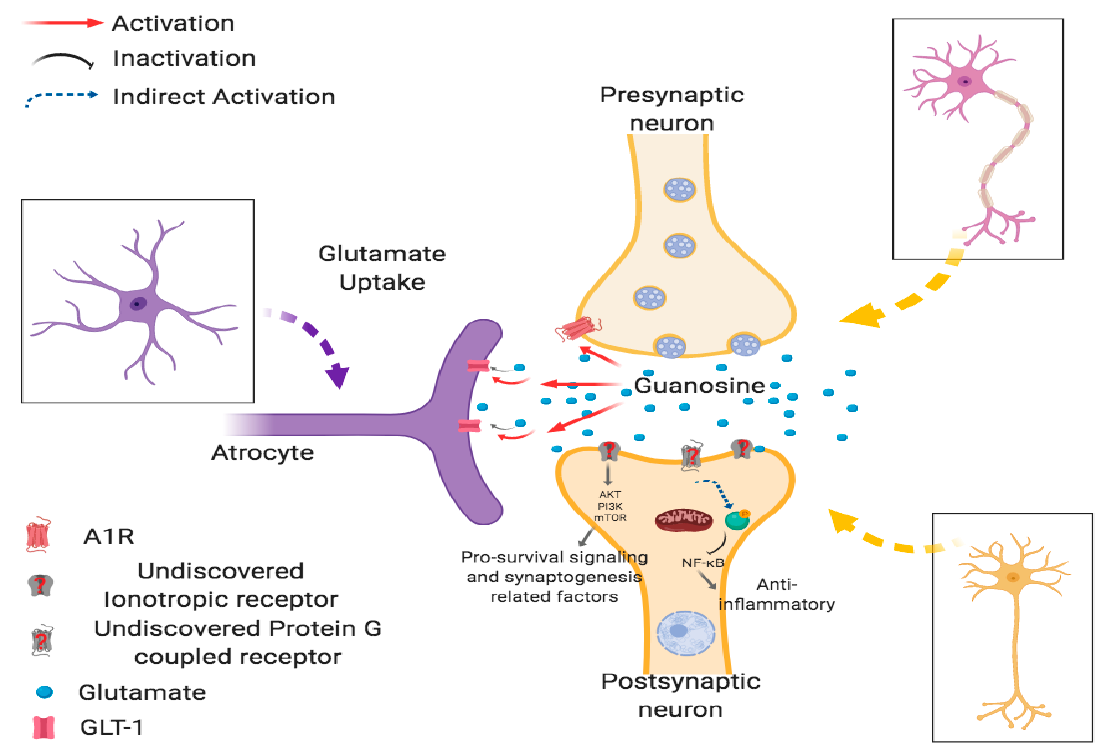
Figure 2. Postulated pathways involved in GUO mechanism of action. Figure was produced with permission using Biorender free version (www.biorender.co). A1R: Adenosine a1 receptor, GLT-1: